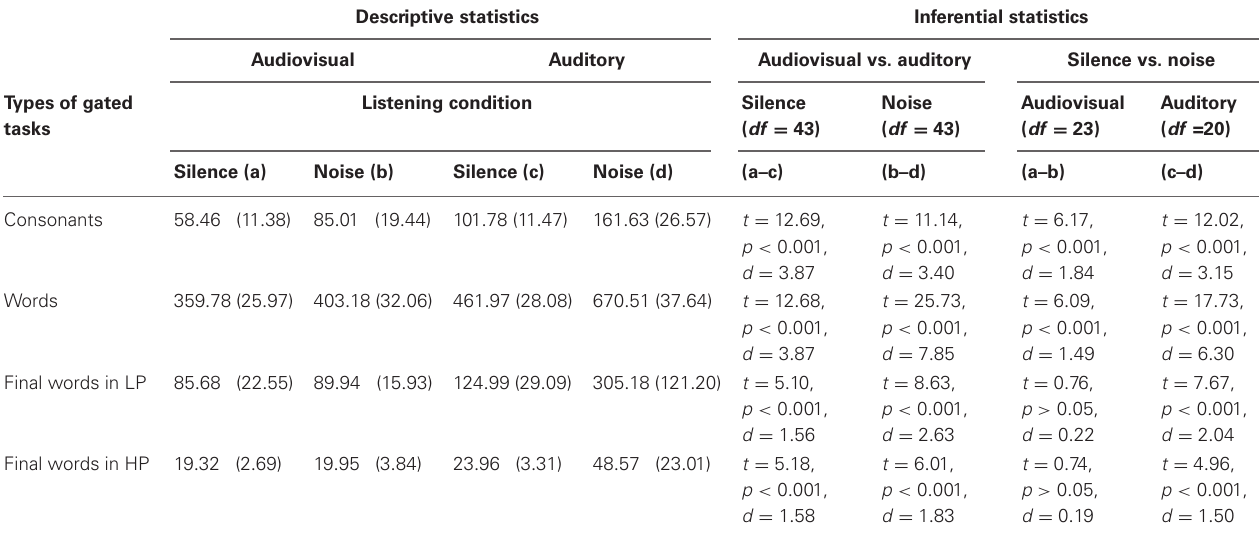
Table 3 | Descriptive and inferential statistics for ips of consonants, words, and final words in HP and LP sentences in silence and noise presented audiovisually and